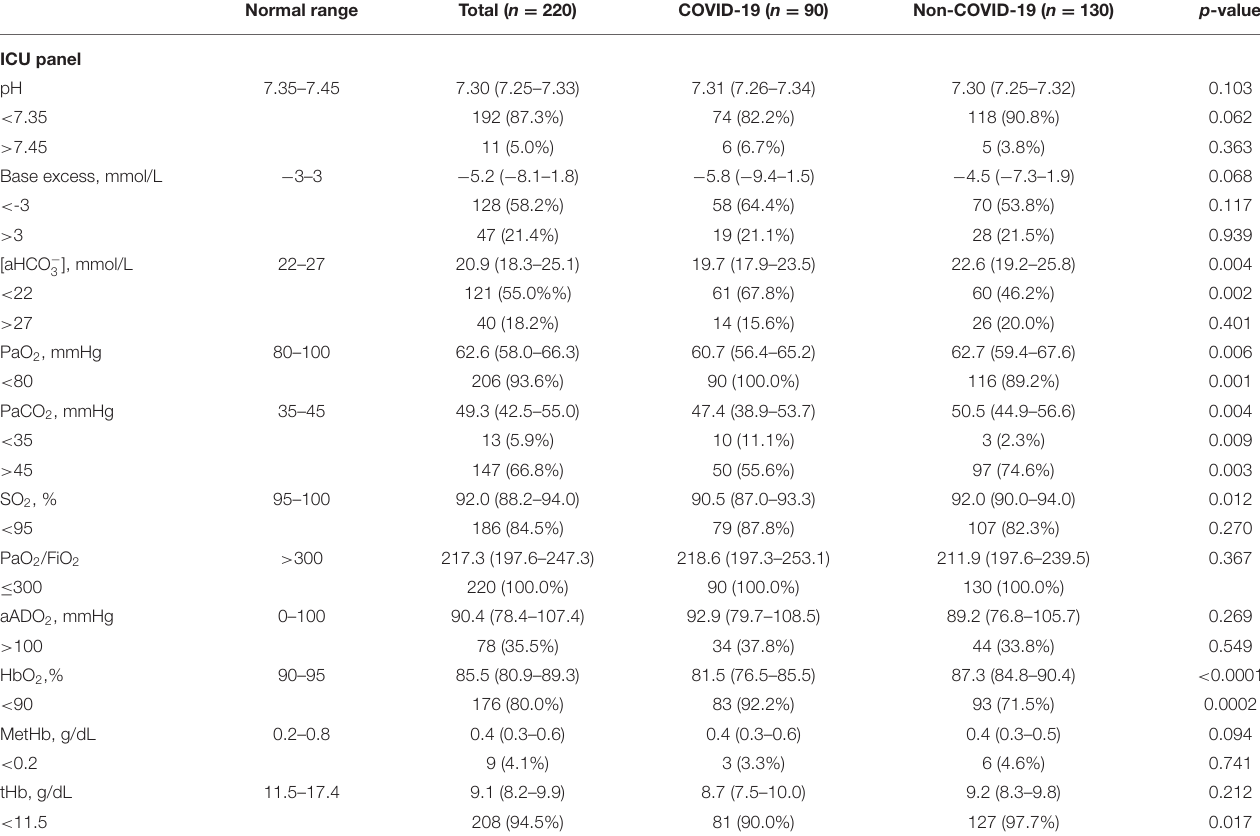
TABLE 3 | Arterial blood gas profiles for ALI patients in the COVID-19 and non-COVID-19 cohorts. Normal range Total ( n = 220) COVID-19 ( n = 90) Non-COVID-19 ( n = 130) p